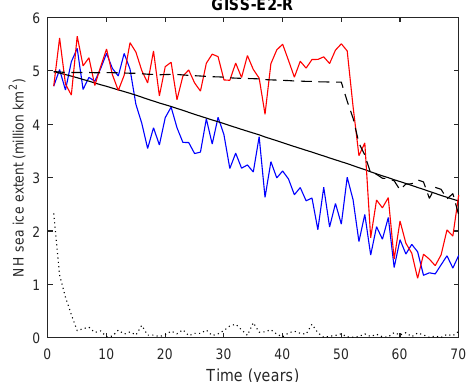
Figure 5. As in Fig. 3 but for Northern Hemisphere annual- minimum sea ice extent. Simulated and emulated responses are shown for 1% per year increase in CO 2 and GeoMIP experiment G2 for one model, GISS E2-R. The dotted line shows the response for the abrupt 4 × CO 2 simulation. The relatively poorer emulator prediction for the 1% CO 2 case in particular illustrates that the lin- earity assumption does not hold for all relevant climate